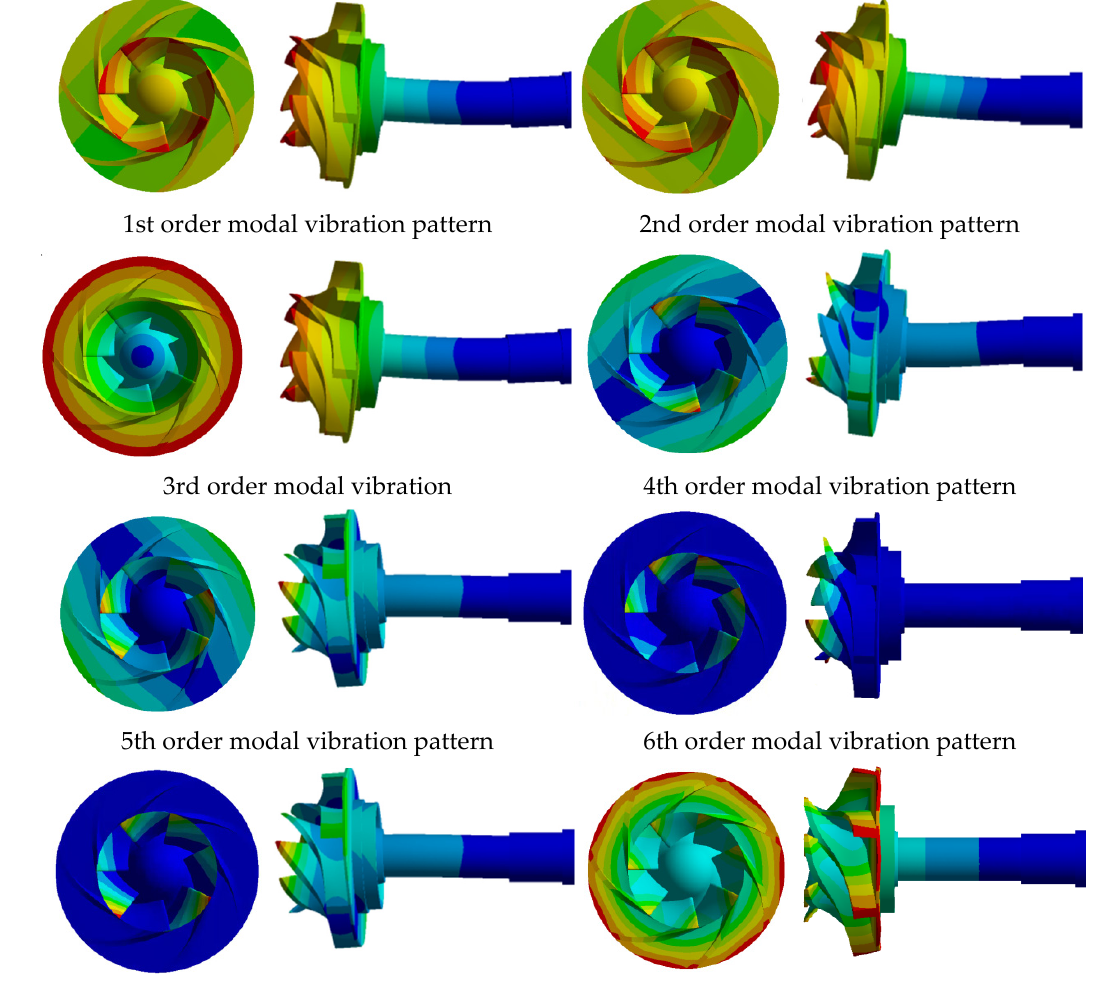
Figure 15. Fore eight modes of case B.